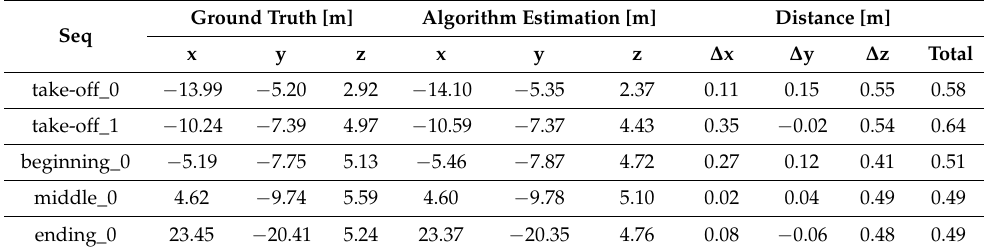
Table 4. Comparative table between the ground truth obtained by the total station and the output of the global location algorithm for the Álora